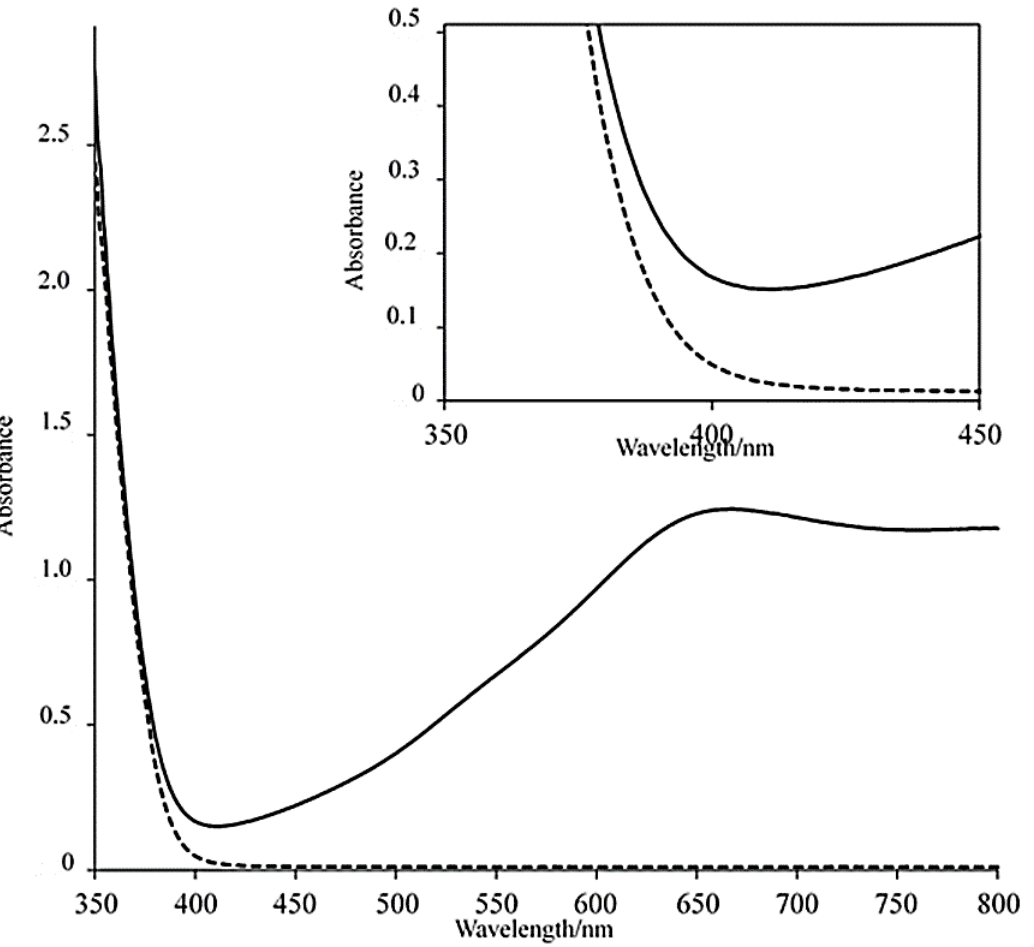
Figure 4. UV–Vis spectra from 350 to 800 nm of TBA-1 (6.6 × 10 − 4 M) in DMSO / methanol (83:17 vol%) solution before (dashed line) and after 30 min of light irradiation (solid line). In set: the absorption at 350–450 nm.